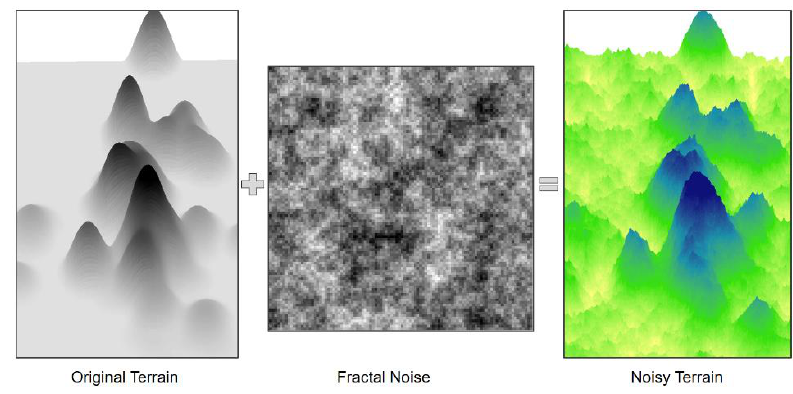
Figure 13. Illustration of fractal noise synthesis.